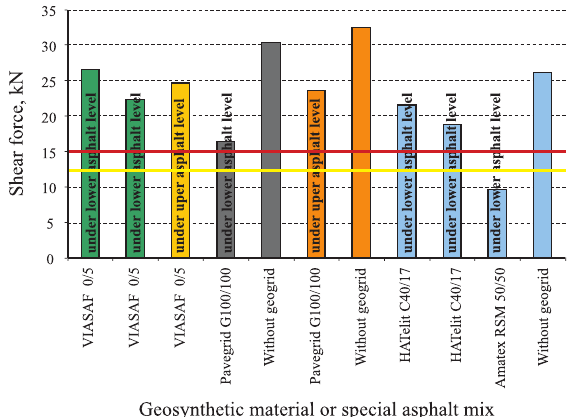
Fig. 3. Distribution of the bonding strength of asphalt layers depending on geosynthetic material or special asphalt mix in the interlayer: – the lowest permissible bonding strength between the upper and lower asphalt layers , – the lowest permissible bonding strength between all the other layers according to ĮT ASFALTAS